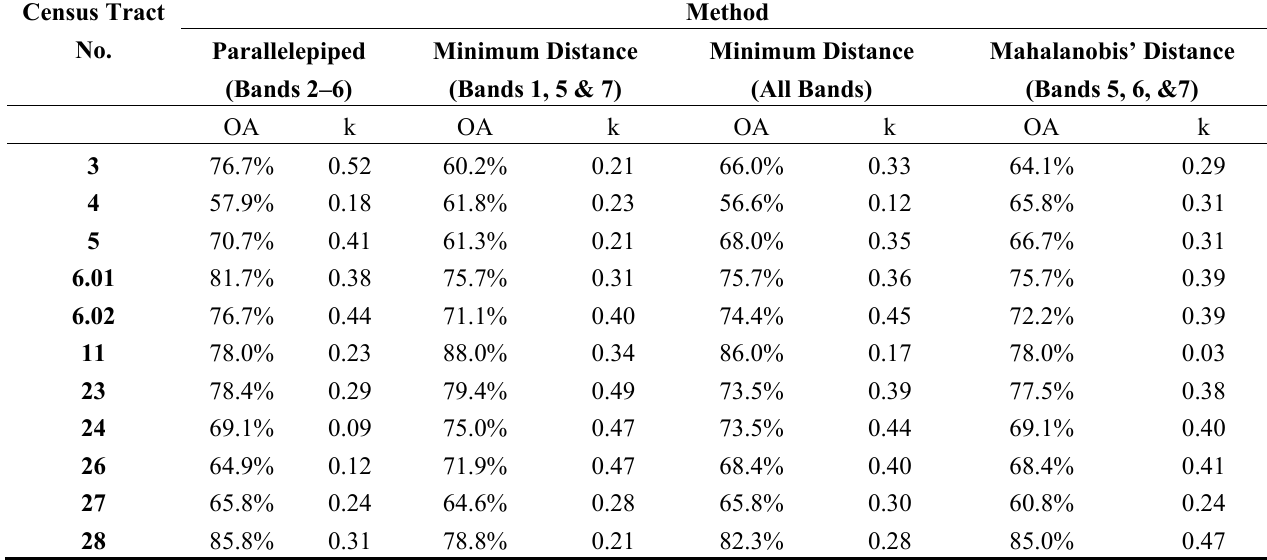
Table 7. Overall accuracy (OA) and kappa (k) for each of the four chosen classified images, listed by census